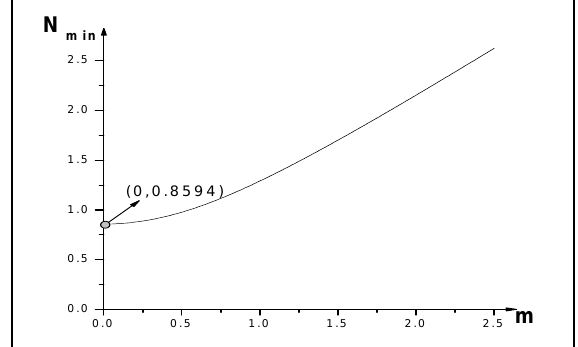
Figure 6. The rationship curve graph of